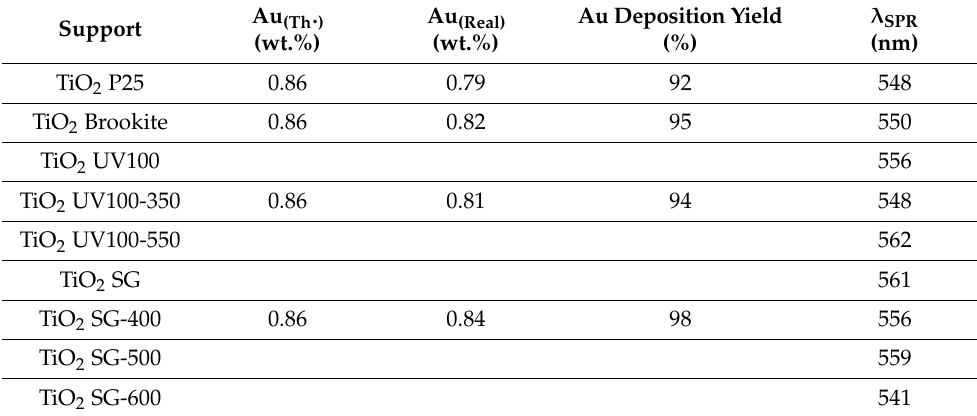
Table 2. Au content and deposition yield determined from ICP. Experimental error of 6%. Au (Th . ) Au (Real) Support (wt.%)